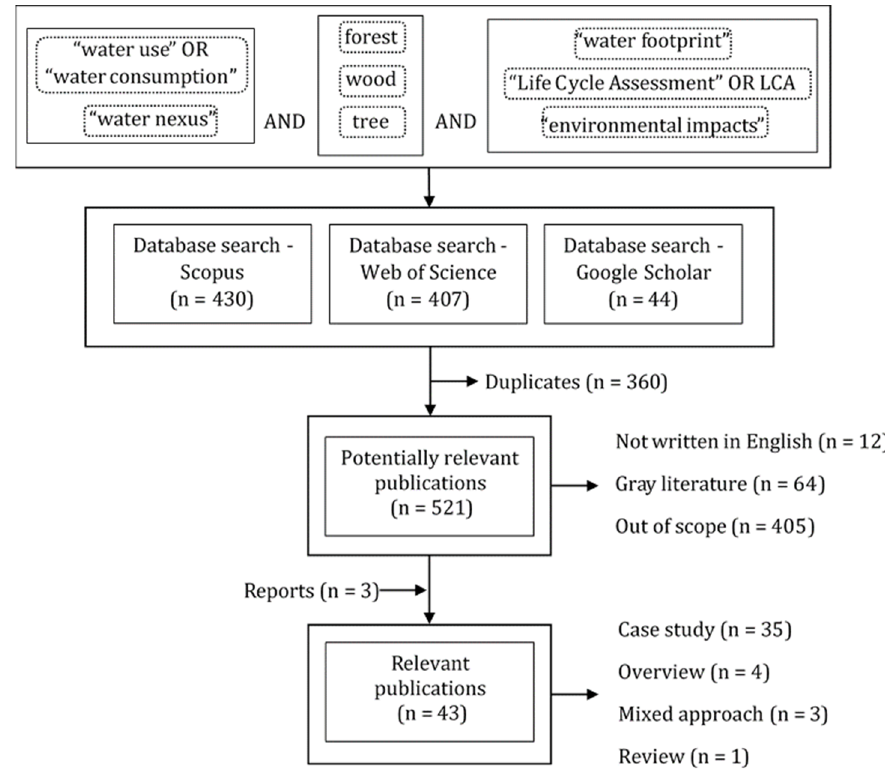
Figure 1. Flowchart of the review.